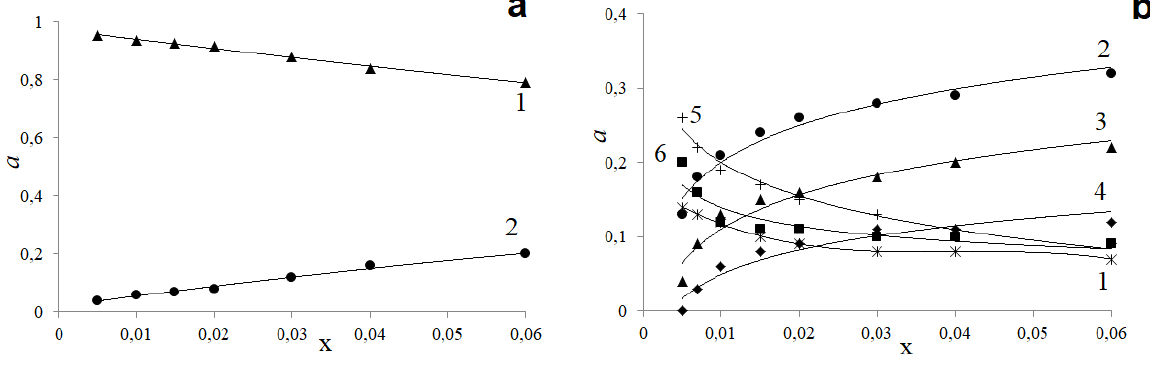
(2) and ferromagnetic a dim ( f ) Fe ( III ) Fe ( III ) (4) and Fe ( III )